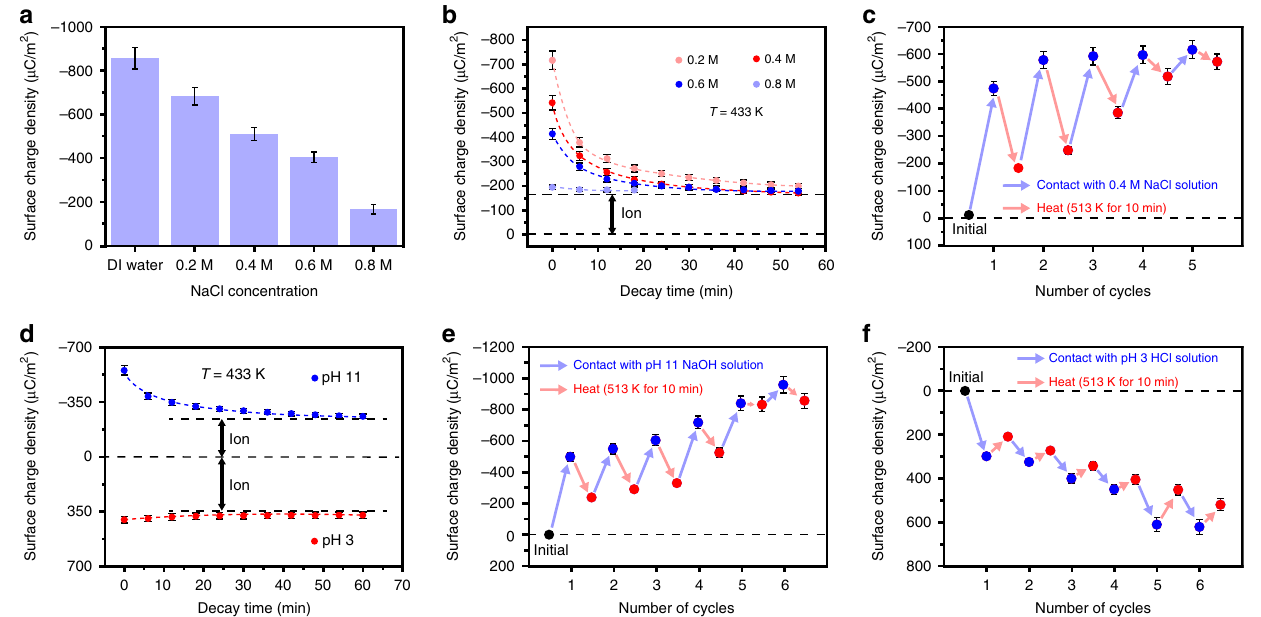
Fig. 2 Temperature effect on the CE between the SiO 2 and aqueous solutions. ( a ) The effects of the NaCl concentration on the CE between the SiO 2 and the NaCl solutions. ( b ) The decay of the CE charge at 433 K which is induced by contacting with the NaCl solutions. ( c ) The CE charge density on the SiO 2 sample surface in the charging (contacting with 0.4 M NaCl solution at room temperature) and heating (513 K for 10 min) cycle tests. ( d ) The decay of the CE charge at 433 K, which is induced by contacting with the pH 11 HCl solution and the pH 3 NaOH solution. The charging and heating cycle testes when the liquids are ( e ) the pH 11 NaOH solution and ( f ) the pH 3 HCl solution. (Error bar are de fi ned as s.